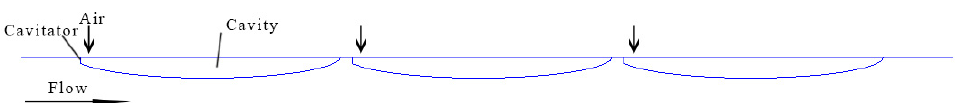
Figure 11. Concept of the air cavity system. The cavities are formed behind vertical cavitators. The number of cavities depend on the velocity.